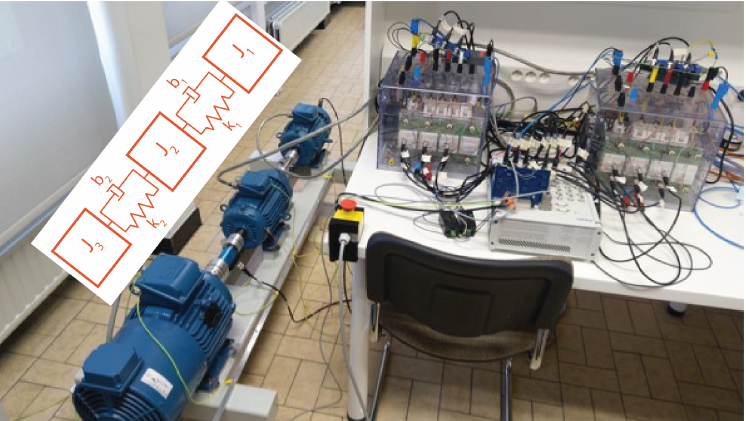
Figure 3. Test setup used for experimental validation: left, the mechanical drivetrain; right, the in- verters and data acquisition